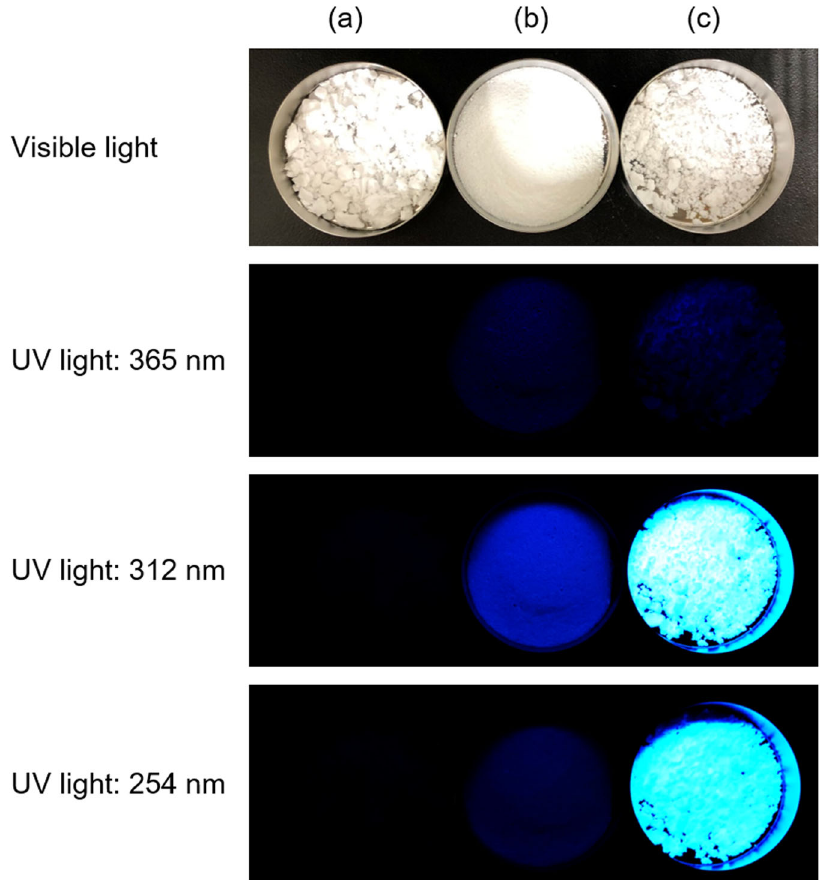
Fig. 7 Images of samples under visible and UV light (365, 312, and 254 nm). (a) Plain OCP (CONTROL), (b) pyromellitic acid, and (c) OCP with incorporated pyromellitate ions